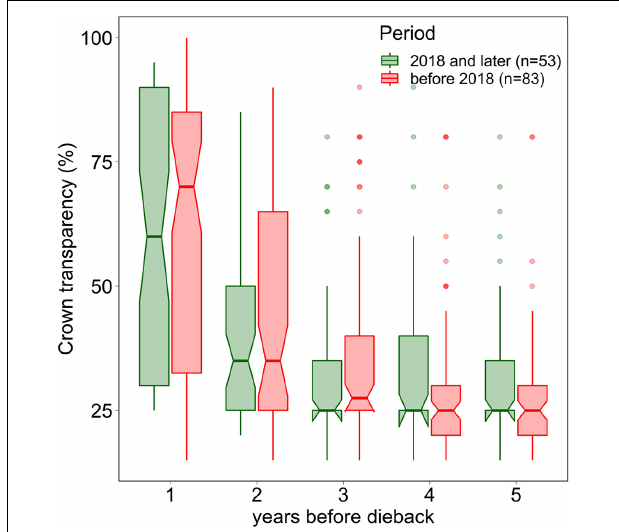
FIGURE 3 | Crown transparency of beech in the years before dieback before 2018 (1984–2017) and in the years 2018, 2019, and 2020. Notches indicate a 95% confidence